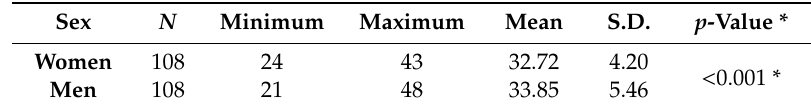
Table 4. Mean age based on sex.